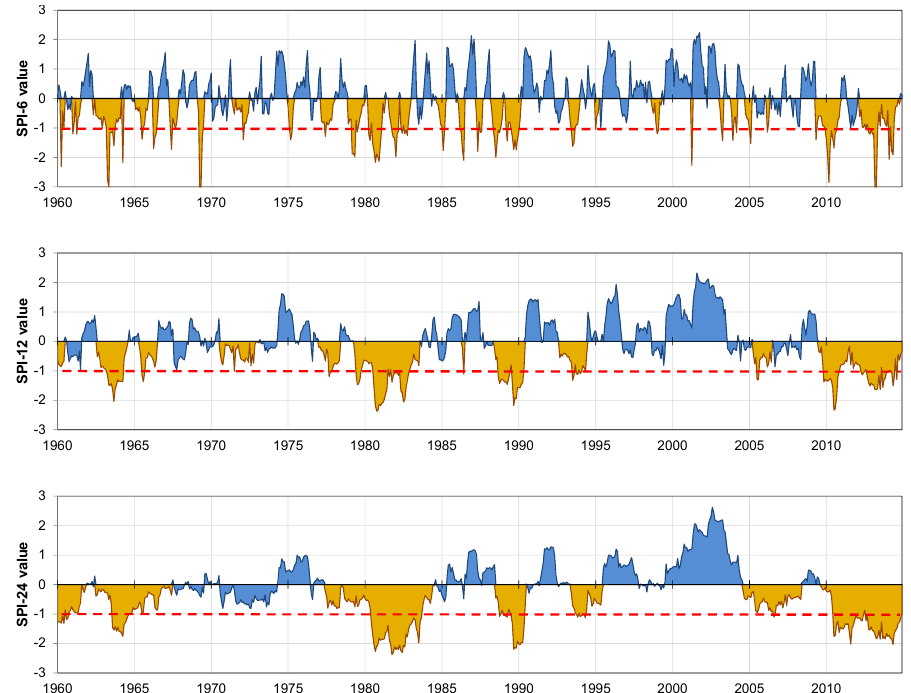
Figure 2. Example of the SPI-6, SPI-12 and SPI-24 series at the Chuxiong station, indicating drought periods in orange (lower threshold in red).